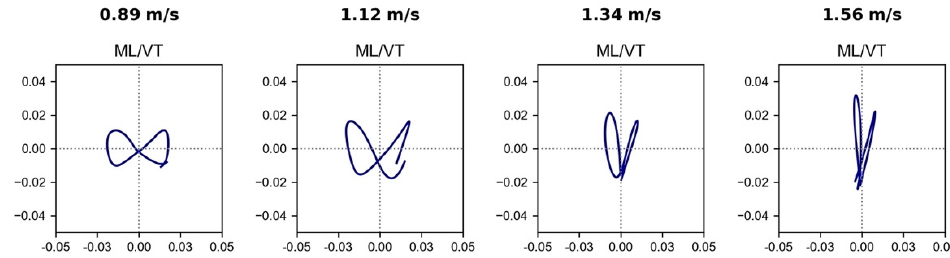
Figure 1. The ML/VT displacement trajectory of the BCOM during a stride. The vertical and horizontal axis indicate displacement in the VT and ML direction.